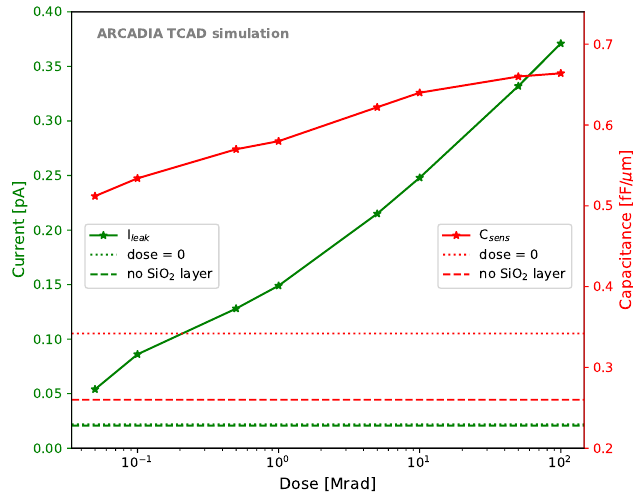
Figure 12. Leakage current I leak (green) and sensor capacitance C sens (red) as a function of the total ionizing dose for a 50 µ m thick microstrip sensor. The values obtained in simulations with and without the SiO 2 layer in the absence of irradiation are shown as horizontal lines and referred to as “dose = 0” and “no SiO 2 layer”, respectively.